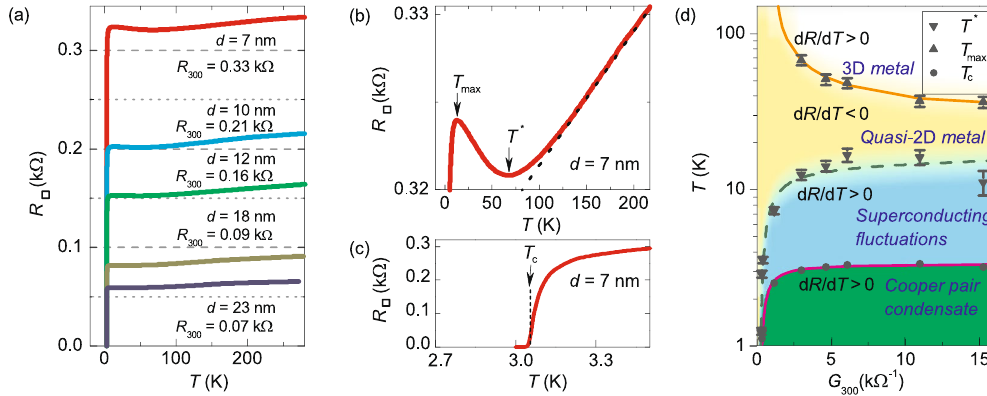
Figure 1. Reentrant temperature dependence of the resistance and phase diagram. ( a ) Resistance per square vs. temperature for five TiN films with different thicknesses d and different resistances at room temperature R 300 . ( b , c ) The enlarged areas from panel (a) for sample d = 7 nm. ( b ) Magnified representation of R ( T ) above the superconducting transition. All the samples exhibit the same behaviour. Arrows mark temperatures T * and T max . Dashed line corresponds to R ∝ T . ( c ) Magnified representation of R ( T ) near the superconducting transition. Arrow marks the superconducting critical temperature T c determined from the quantum contribution fits (see Fig. 3a and details in the text). ( d ) The phase diagram for low- T c thin TiN films in conductance ( G 300 = 1/ R 300 )-temperature ( T ) coordinates. Temperatures T * , T max , T c separate four distinct regimes of R ( T ). The five points at higher G correspond to films in ( a ). Three points for lower G (i.e. lower T c ) corresponds to films from ref. 14, which have no T * value since in these films R ( T ) increases with cooling from room temperature.